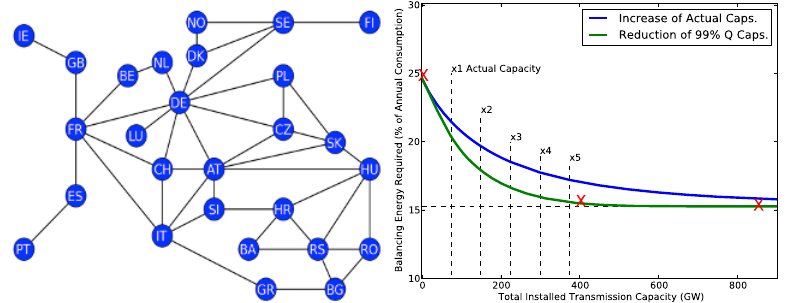
Fig. 5. Left panel: The transmission lines connecting the 27 European countries. This network topology resembles that of the present day European power system. Right panel: As a result of the DC power flow calculation, the average balancing energy of the nodes is shown as a function of the total installed transmission capacity in the network. The significance of the two different curves joining the extreme points is discussed in the text.